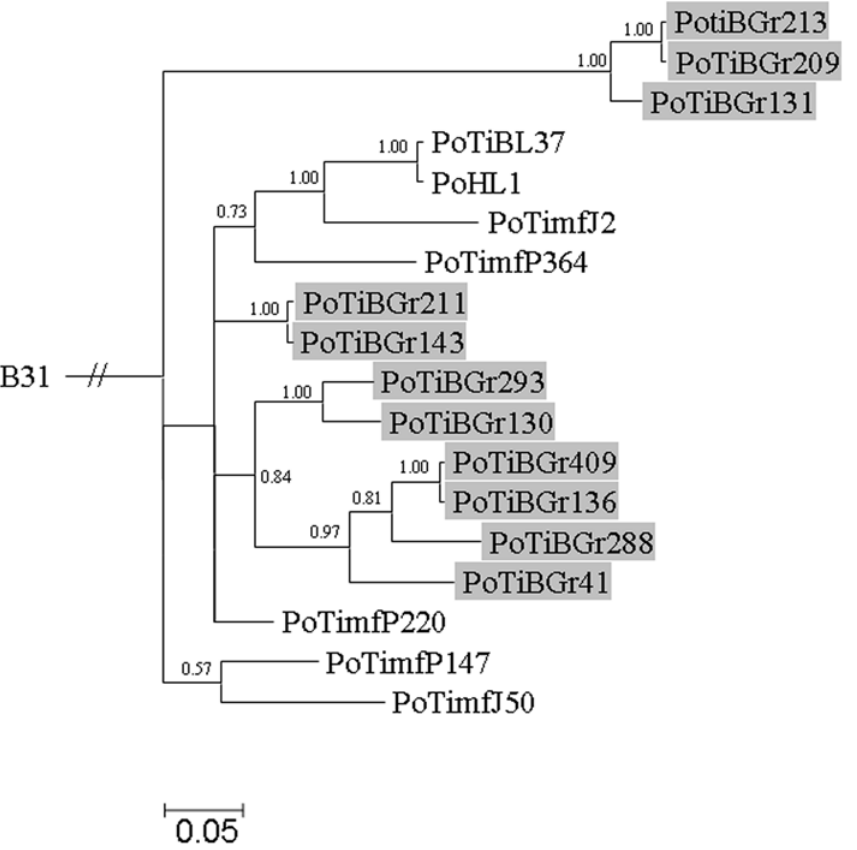
Figure 4. Bayesian phylogenetic tree of B.lusitaniae strains based on ospC . The tree was rooted with B. burgdorferi strain B31. Posterior probabilities values are indicated to provide branch support. The scale bar represents 5% sequence divergence. B. lusitaniae samples derived from Graˆndola are highlighted.